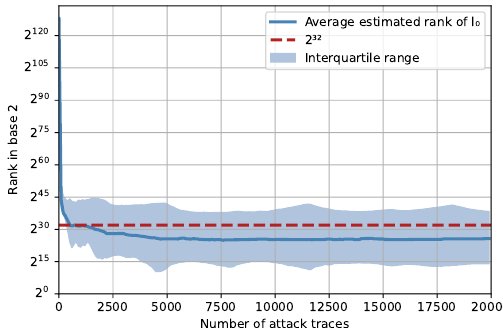
Figure 5: Worst-case attack against l 0 (weakened 8-bit ARM Cortex-M0